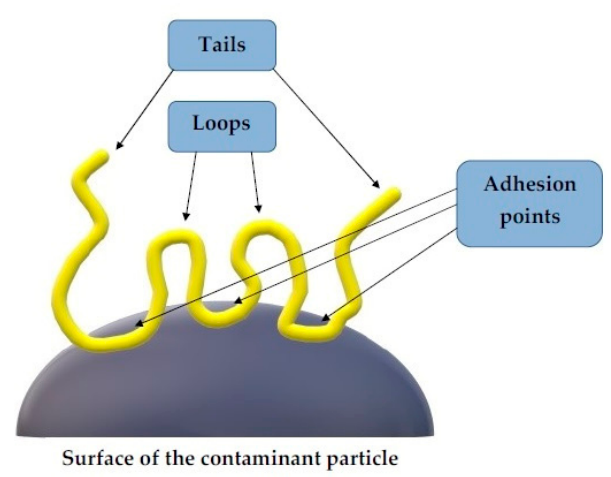
Figure 4. Model of polymer chain adsorbed on contamination particle (according to Bolto [6]) To induce flocculation via bridging mechanism, the size of macromolecules should be larger than double the layer thickness of the colloidal particle. The estimated minimal molecular weight for linear nonionic polymer (polyacrylamide) is about 30,000 Da [28]. The aggregates formed in the